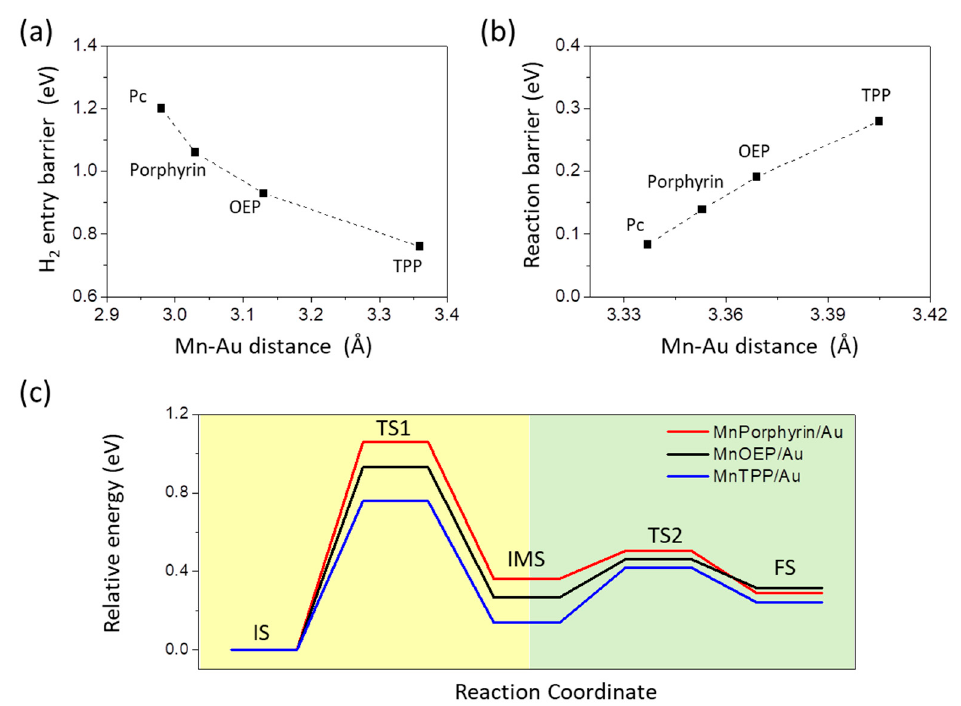
Figure 2. Relationship between catalytic activity and Mn–Au distance for the hydrogen dissociation reaction in an Mn-organic molecule / Au(111) system. ( a ) H 2 entry barrier as a function of Mn–Au distance in initial states. ( b ) H 2 dissociation barrier as a function of Mn–Au distance in Step 2. ( c ) Potential energy landscapes in different quantum nutcracker systems according to ( a , b ). Legend: IS, initial state; IMS, intermediate state; FS, final state; TS1, first transition state; TS2, second transition state.